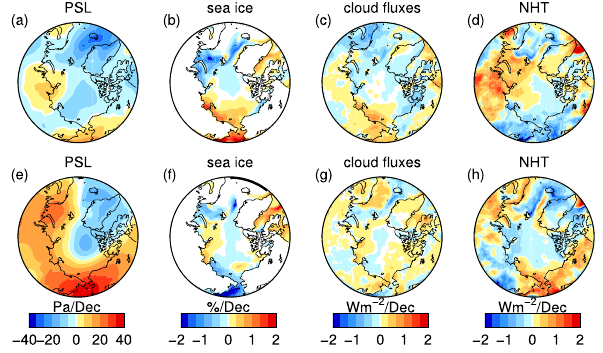
Figure 4 . Linear trends in sea level pressure (PSL), sea ice coverage, cloud net radiative fluxes at top of the atmosphere, and atmospheric northward heat transport (NHT) over the period 1975-2005 in the Arctic due to direct radiative forcing by sulfate only (a, b, c and d) and black carbon only (e, f, g and h), respectively.